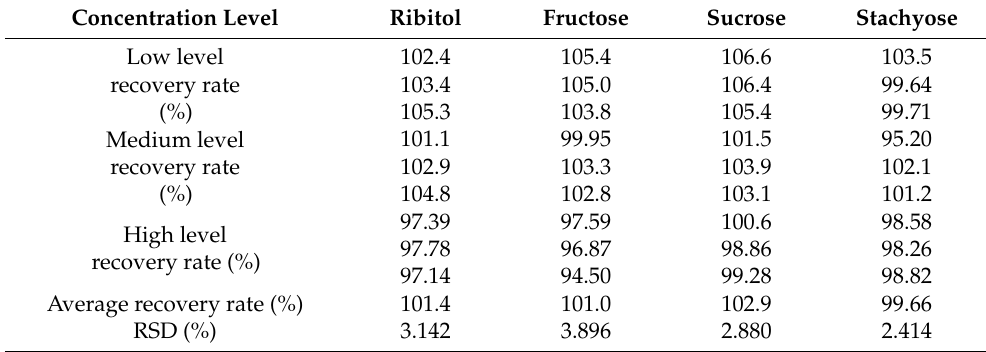
Table 7. Results of recovery experiments.